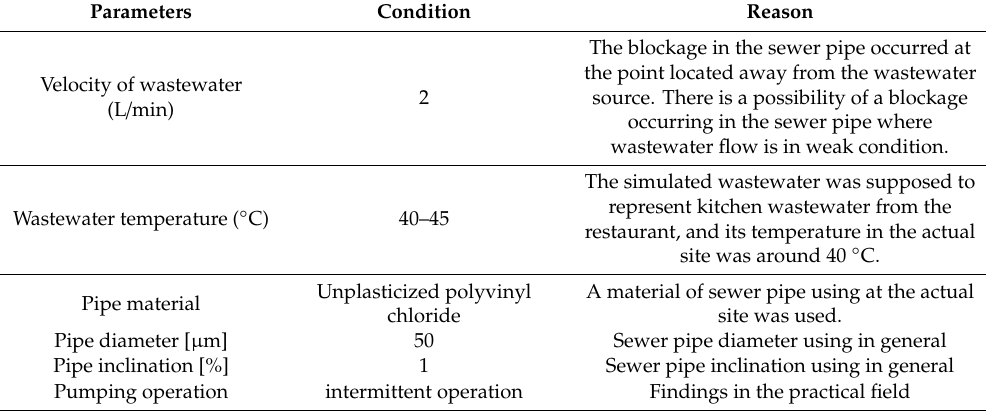
Table 3. Experimental parameters and conditions considering di ff erent parameters of wastewater flow